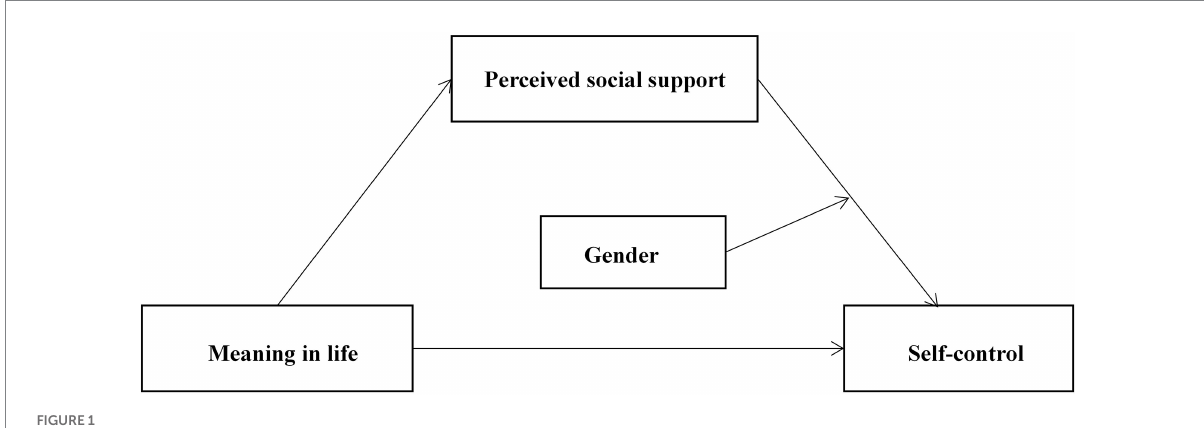
FIGURE 1 Concept